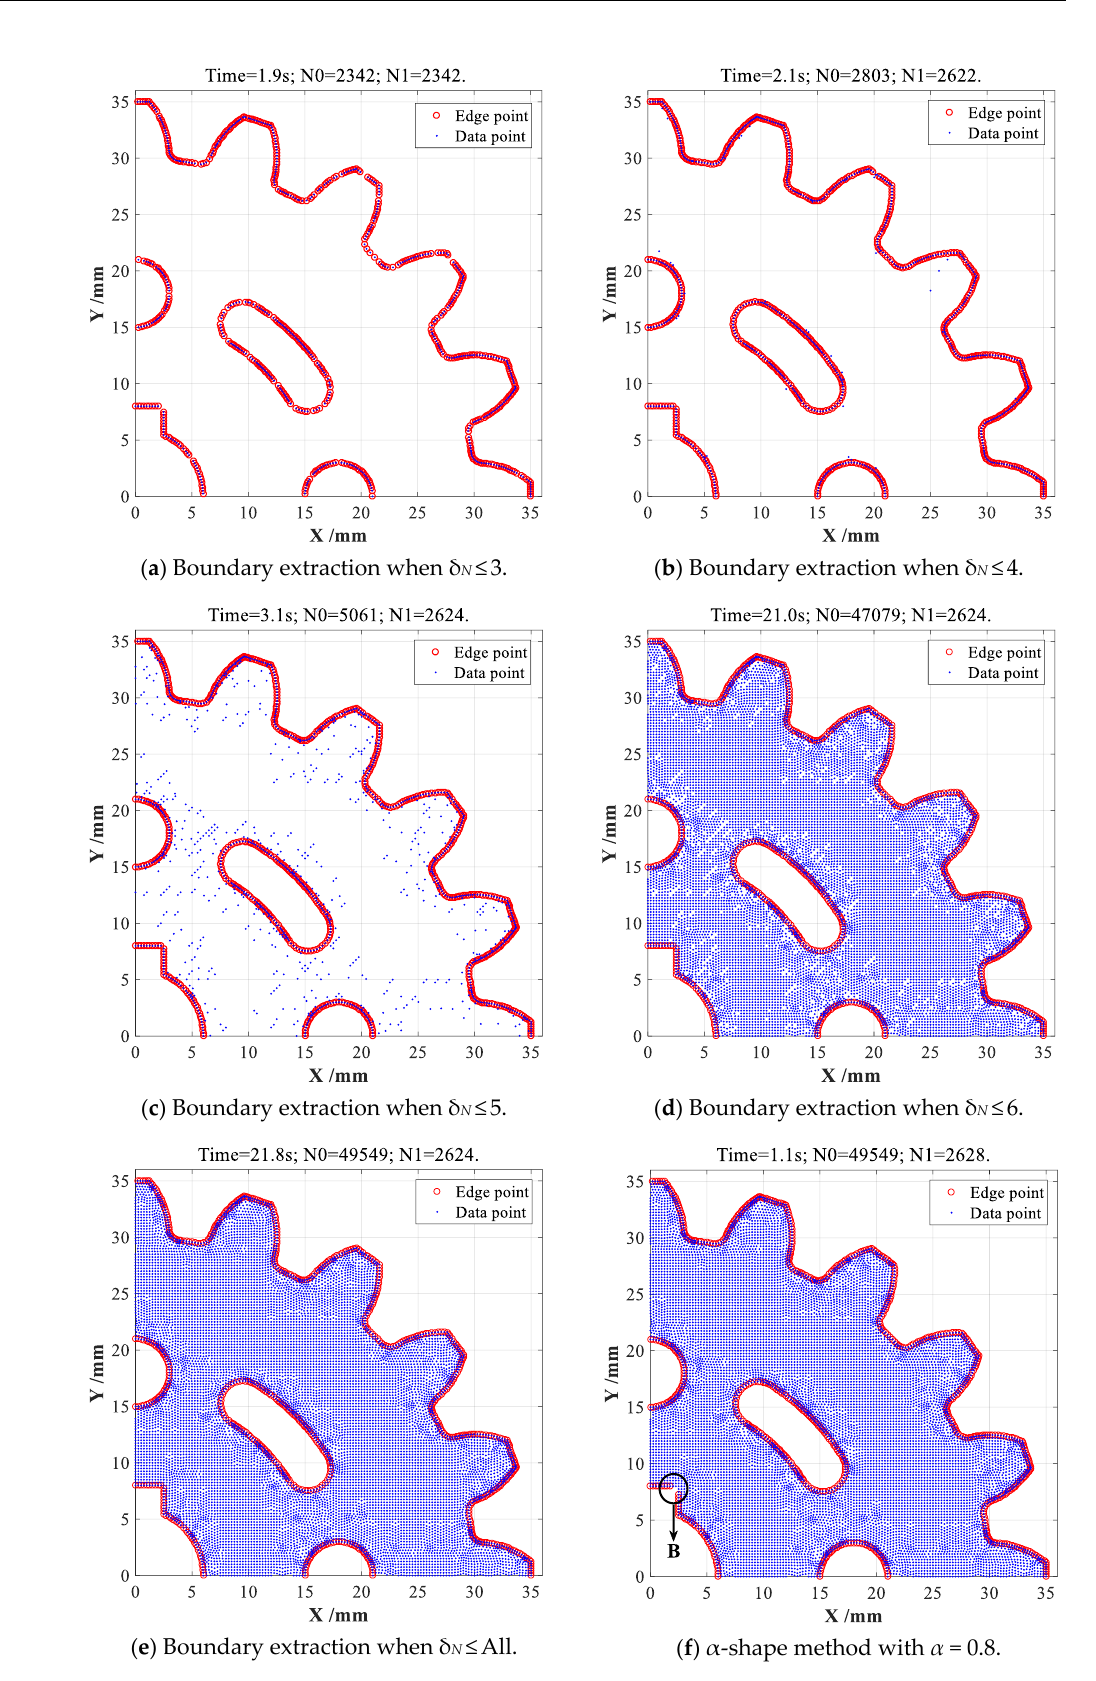
Figure 11. Boundary extractions and performance comparison on gear object under different δ N